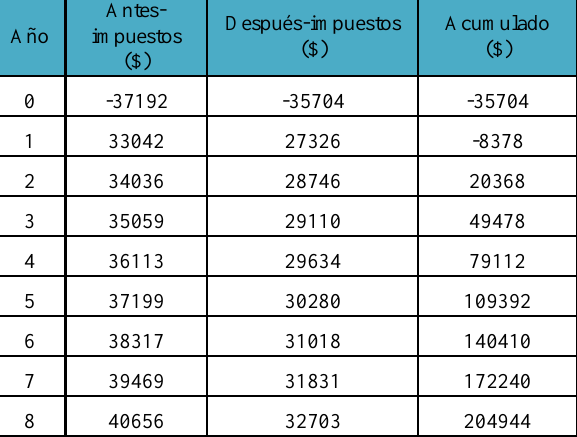
Tabla 5: Flujo de cajas del